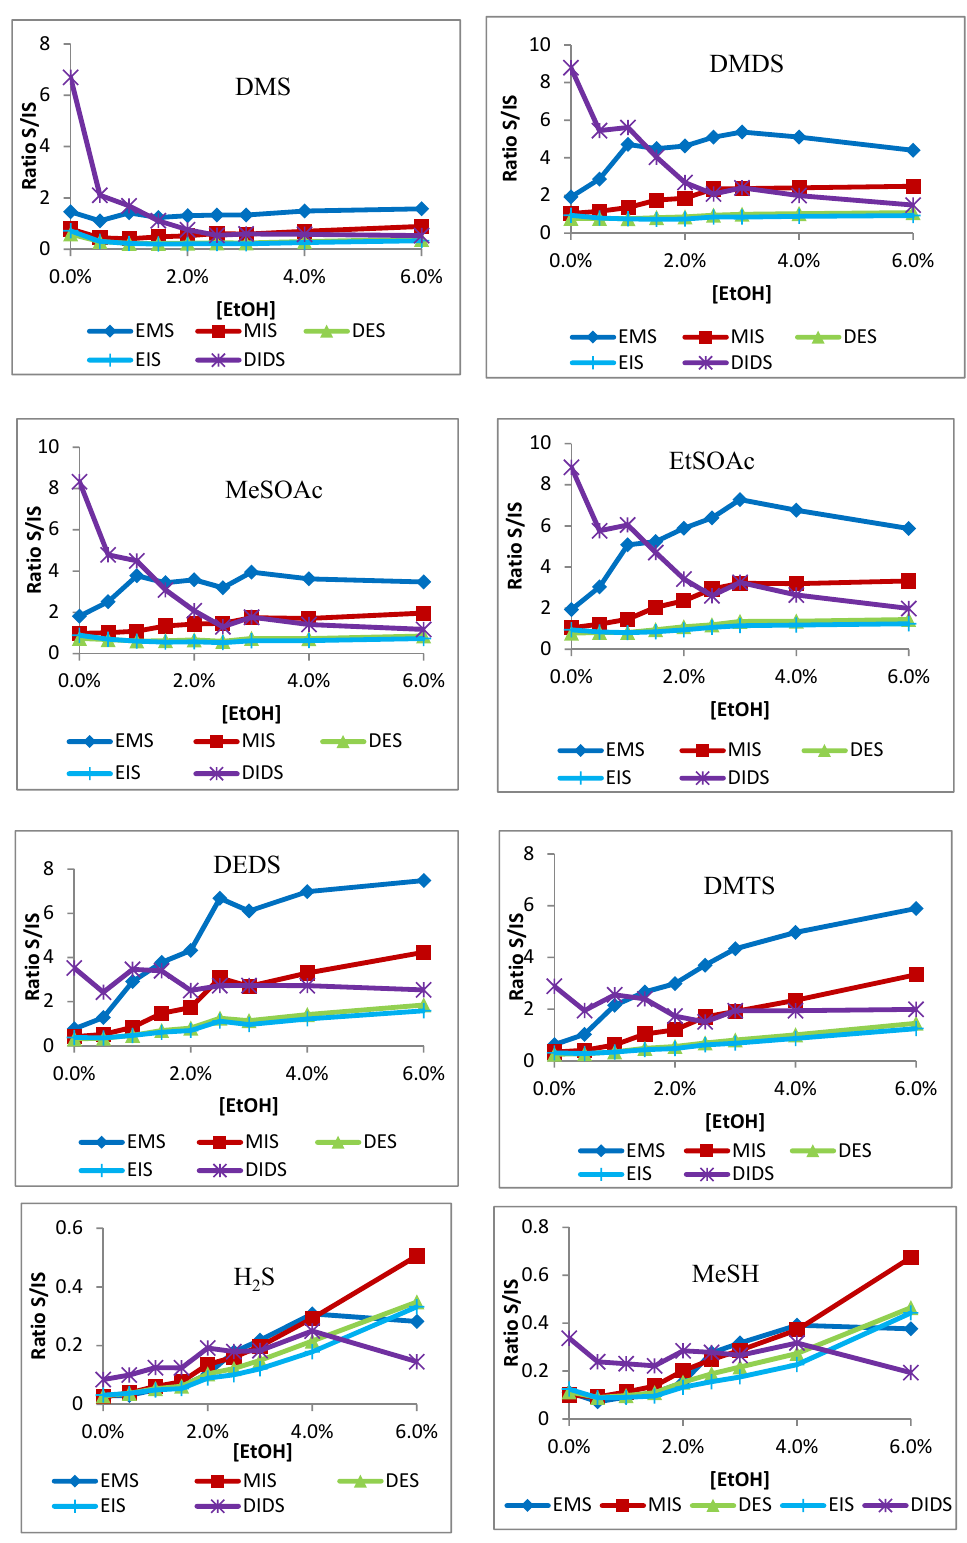
Figure 4. Analyte to internal standard ratios (based on square roots of peak areas) to each of the five internal standards of DMS, DMDS, MeSOAc, EtSOAc, DEDS, DMTS, H 2 S, and MeSH on Carboxen / PDMS